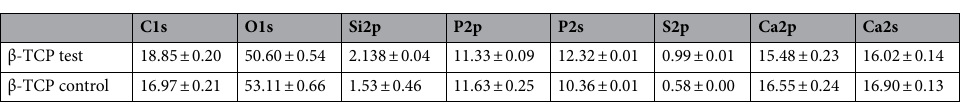
Table 3. XPS analyses (%).